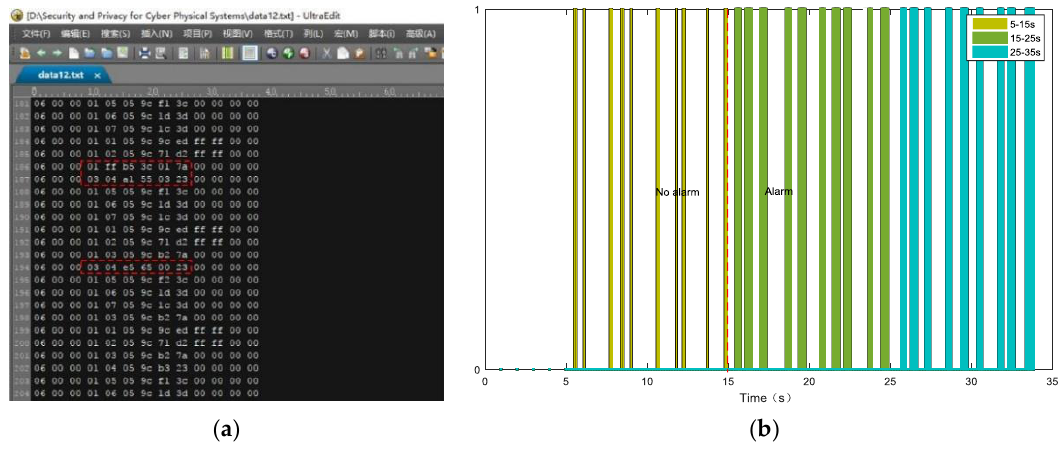
Figure 10. ( a ) The partial test data; ( b ) The results of detection attacks.